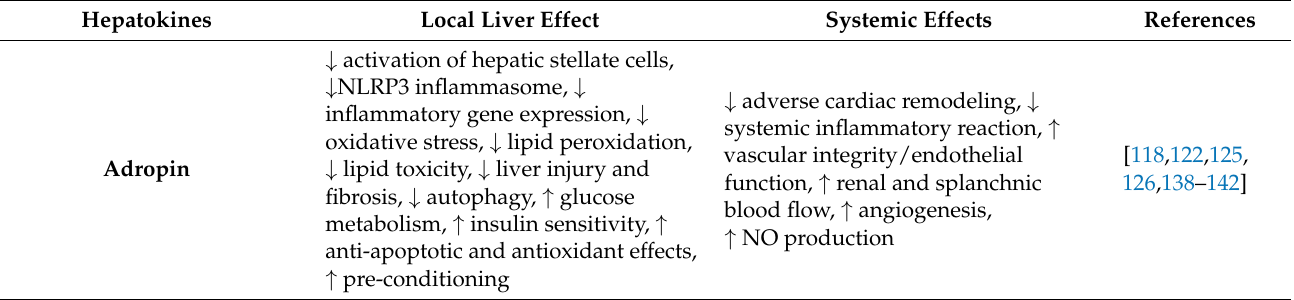
Table 1. Local and systemic effects of hepatokines involved in the pathogenesis of cardiac hepatopathy.